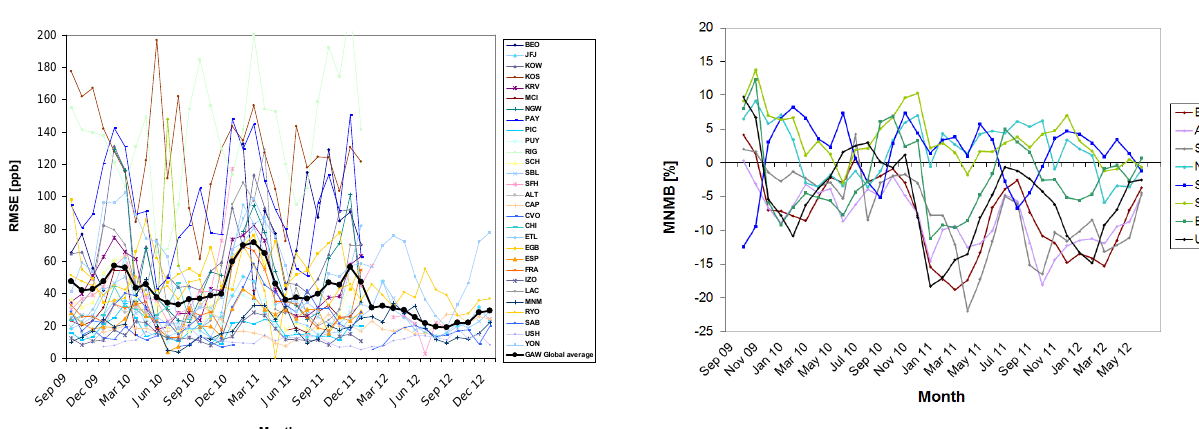
Figure 13. Monthly average of modified normalised mean biases (MNMBs in %) derived from the comparison of the MACC_osuite with MOPITT CO total columns for eight different regions during the period September 2009 to June 2012 (see legend on the